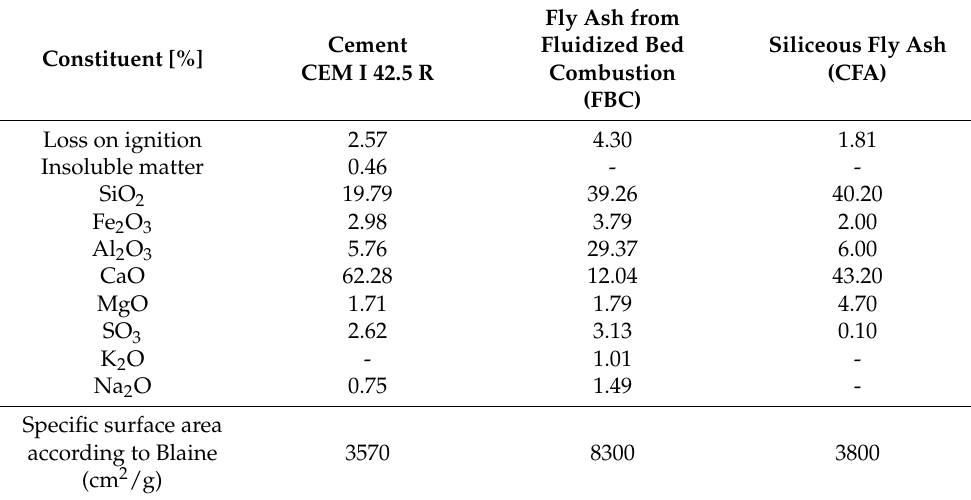
Table 1. Chemical composition of Portland cement (CEM I 42.5 R), fly ash from fluidized bed combustion, and fly ash from siliceous